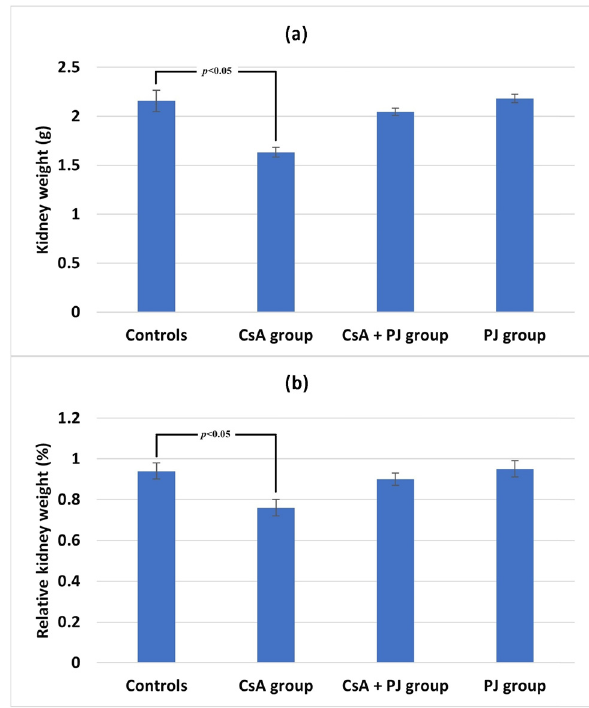
Figure 2: E ff ect of PJ on ( a ) kidney weight and ( b ) relative weight of the kidney of the studied group.